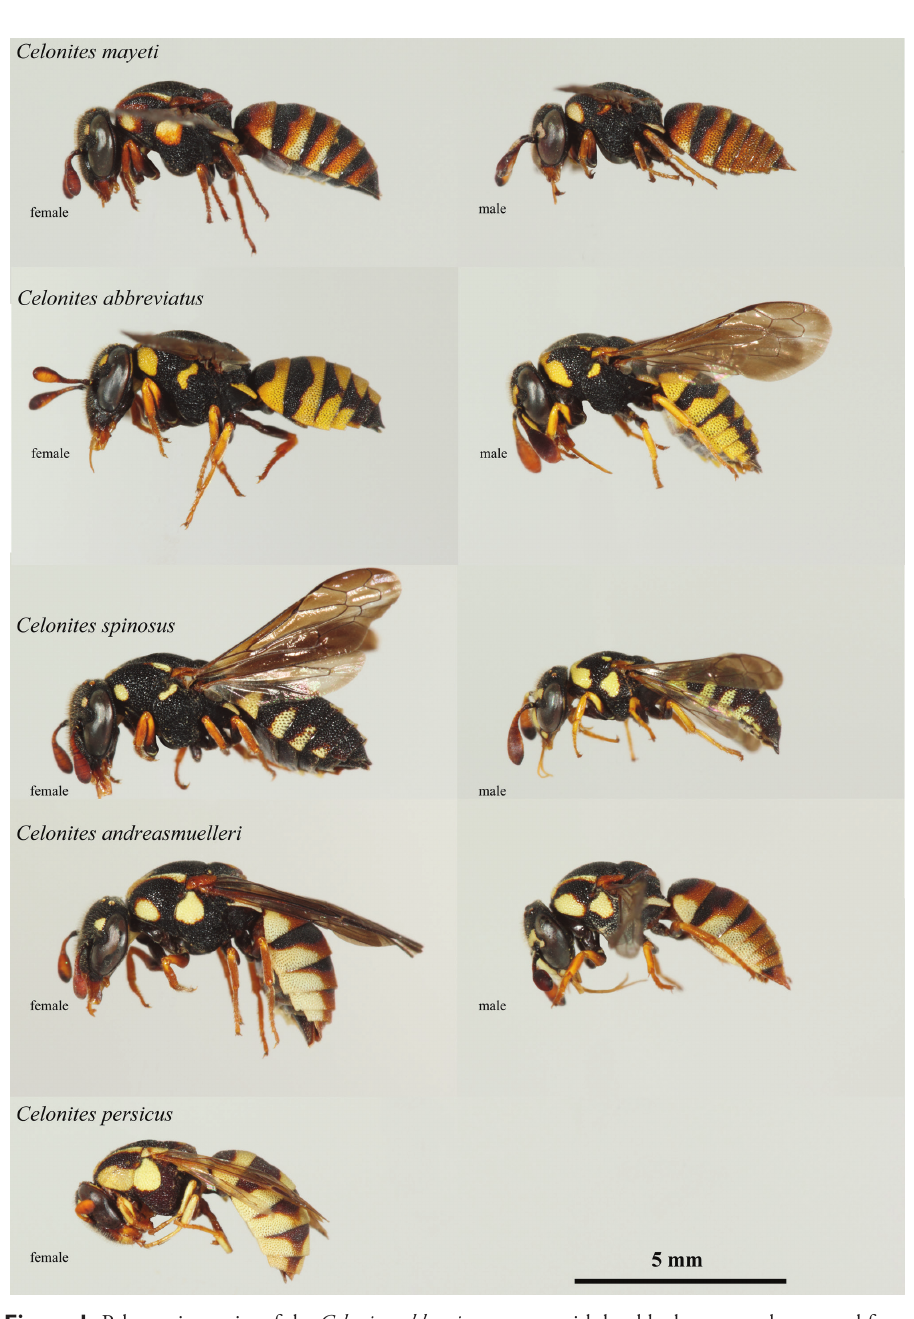
Figure 1. Palaearctic species of the Celonites abbreviatus -group with knobbed setae on clypeus and frons that represent the Celonites abbreviatus -complex in lateral view ( C. mayeti female dbM No. 3462, male dbM No. 3457; C. abbreviatus female dbM No. 3458, male dbM No. 3459, C. spinosus female dbM No. 3428, male dbM No. 3430; C. andreasmuelleri female dbM No. 3072, male dbM No. 3454; C. persicus female dbM No.